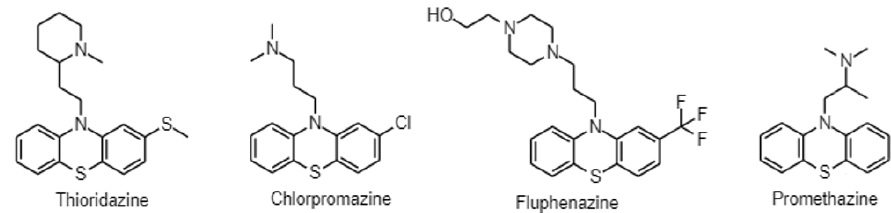
Figure 3. Chemical structure of phenothiazines.